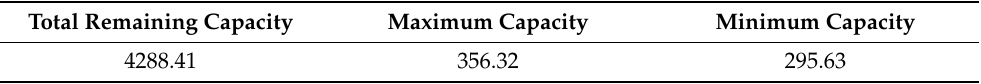
Table 4. Total remaining capacity and maximum and minimum capacity required for harmonic mitigation (kW).